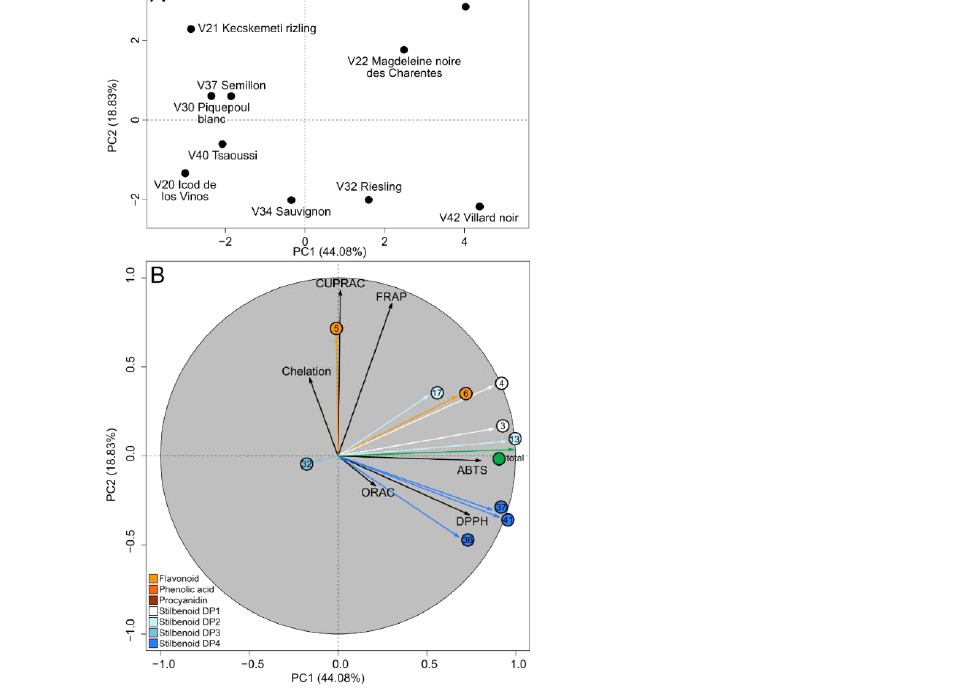
Figure 2. Unsupervised classification using PCA performed on polyphenol-enriched extracts for both antioxidant capacities and polyphenol contents. Score plot ( A ). Loading plot ( B ) with variables colored according to polyphenol class.